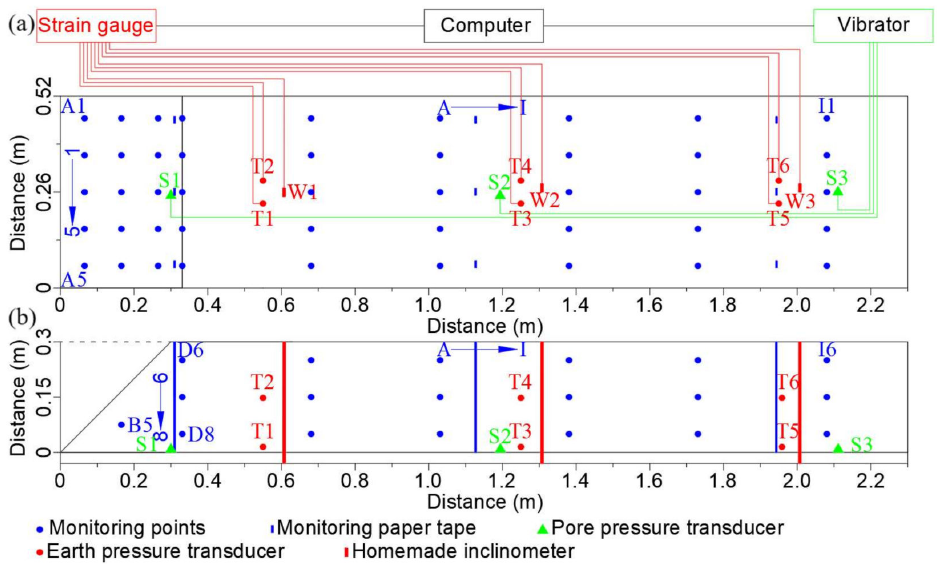
Figure 7. Distribution map of monitoring equipment ( a ) plan view; ( b ) side